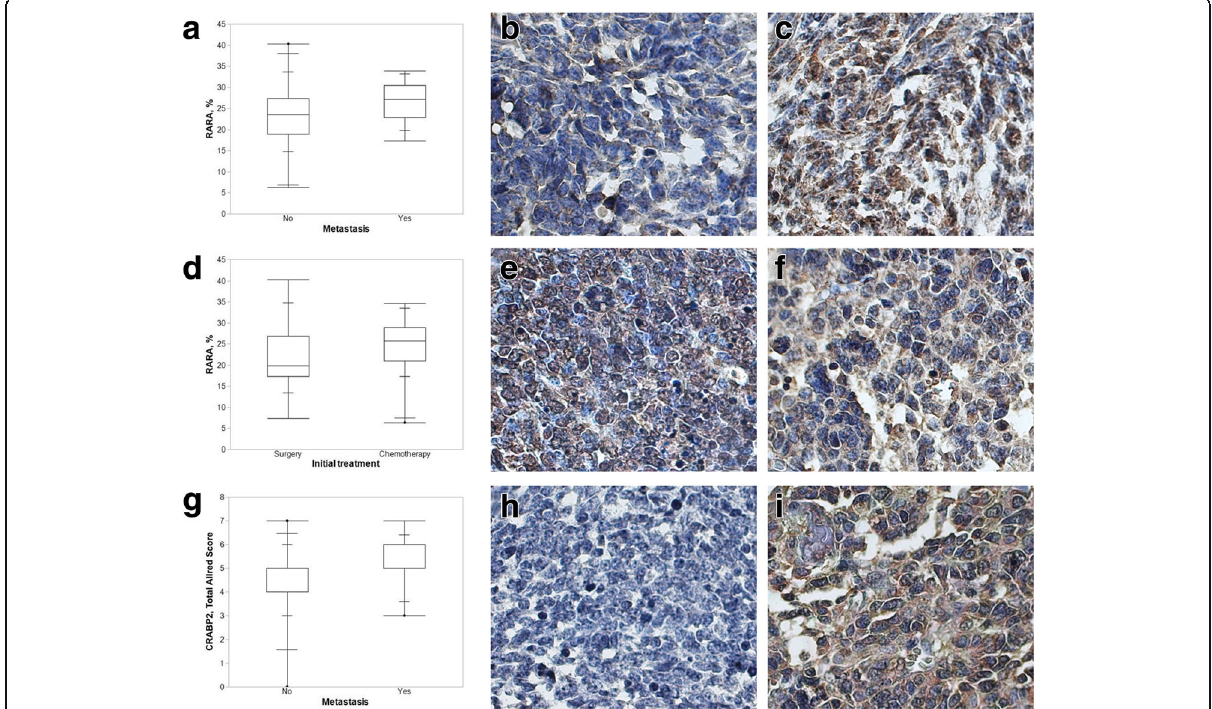
Fig. 2 a Quantitative analysis of RARA immunoexpression as a function of the presence of metastasis. The box-plot represents the results of the quantitative analysis of RARA immunoexpression according to the presence of metastasis, showing RARA immunoexpression in nephroblastomas with and without metastasis. Increased immunopositivity was observed in patients with metastasis ( p = 0.0247). b and c Immunohistochemical expression of RARA in nephroblastomas without ( b ) and with metastasis ( c ) (63×). d Quantitative analysis of RARA immunoexpression as a function of the initial treatment. The box-plot represents the results of the quantitative analysis of RARA immunoexpression according to the type of initial treatment, showing RARA immunoexpression in nephroblastoma samples from patients subjected to pre-surgical chemotherapy and patients subjected to surgery as initial treatment ( p = 0.0330). e and f Immunohistochemical expression of RARA in nephroblastoma samples from patients subjected to surgery ( e ) and pre-surgical chemotherapy ( f ) (63×). g Semiquantitative analysis of CRABP2 immunoexpression as a function of the presence of metastasis. The box-plot represents the results of the quantitative analysis of CRABP2 immunoexpression according to the presence of metastasis, showing CRABP2 immunoexpression in nephroblastomas with and without metastasis. Increased immunopositivity was observed in patients with metastasis ( p =0.0128). h and i Immunohistochemical expression of CRABP2 in nephroblastoma without ( h ) and with metastasis ( i )